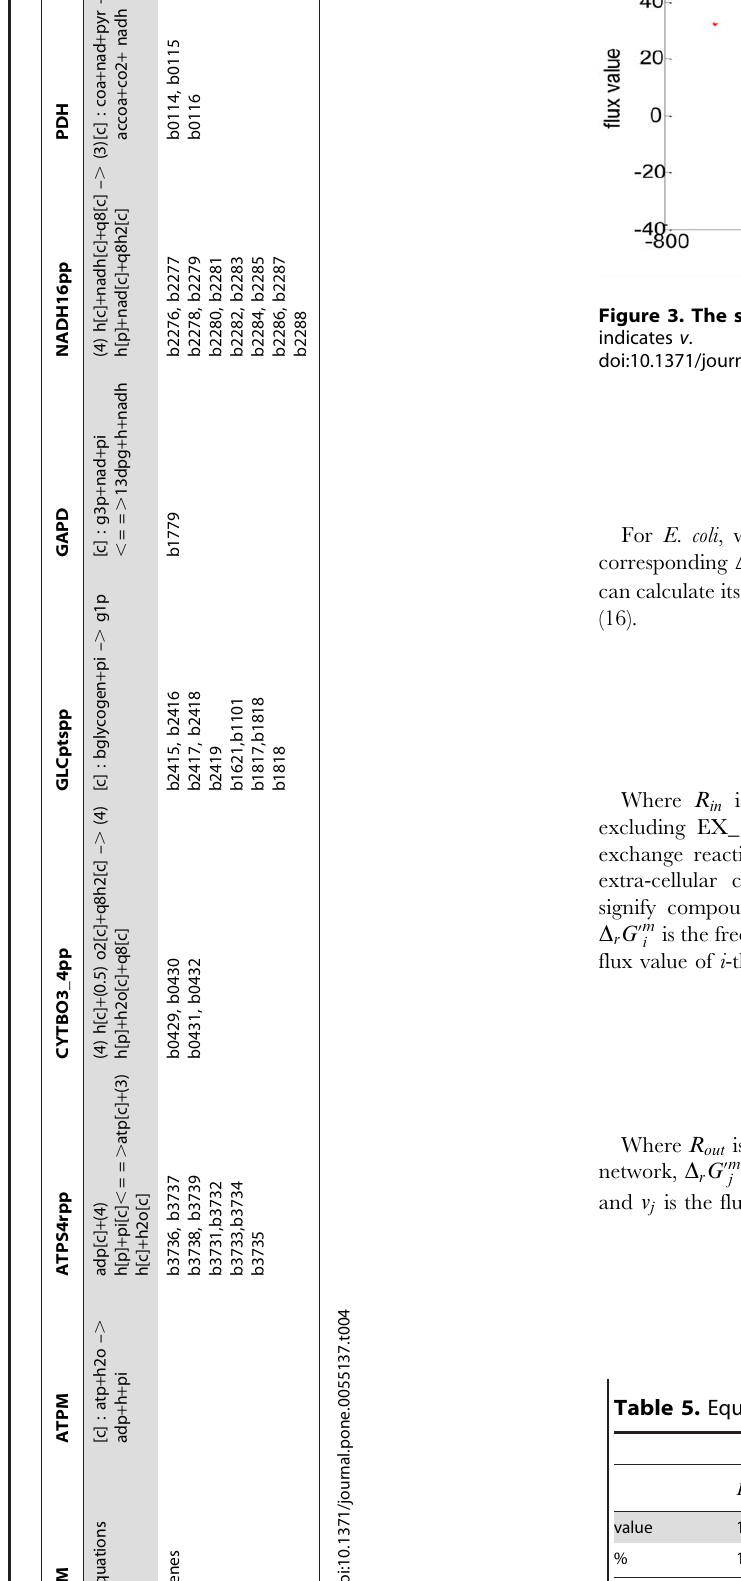
Where R out is the set of EX_ & DM_ reactions of the metabolic is the free energy change of j -the reaction in R out network, D r G ’ m j and v j is the flux value of j -th reaction in R out .